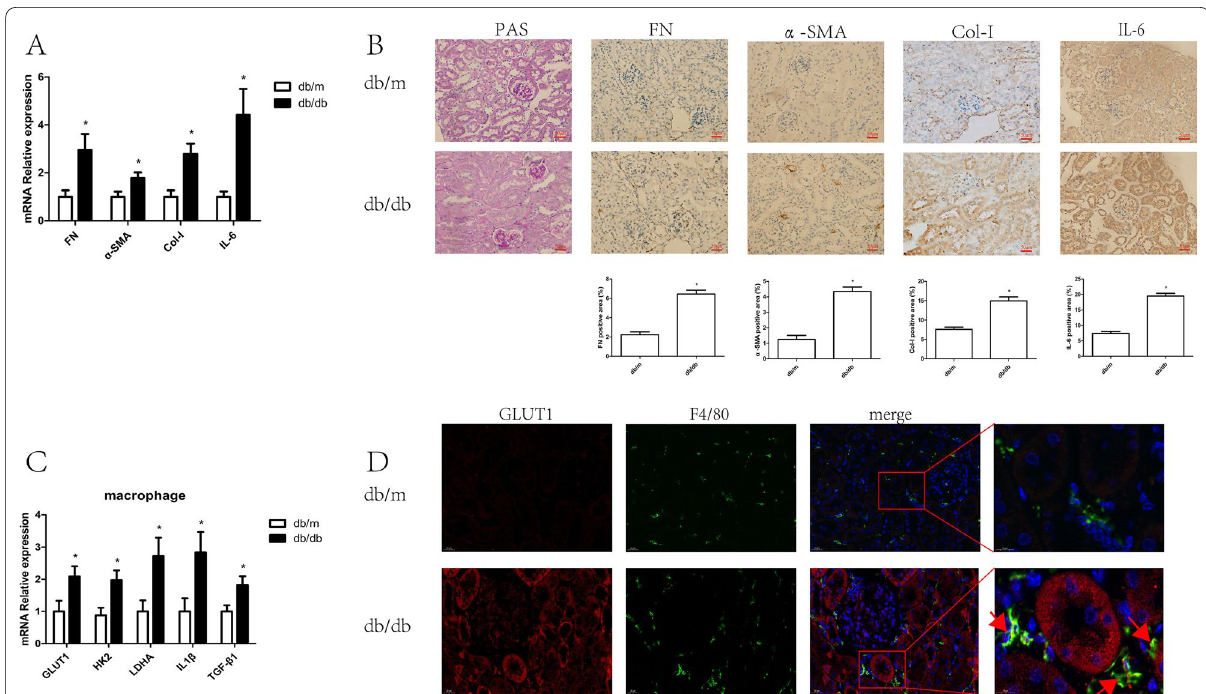
Fig. 1 Glycolysis increased in diabetic kidney macrophages. A The mRNA expression of FN, α-SMA, Col-I and IL-6 in the kidney cortexes of db/m (n 5) and db/db (n 5) mice. B PAS staining and immunostaining of FN, α-SMA, Col-I and IL-6 (original magnification = = of db/m (n 5) and db/db (n 5) mice. C mRNA expression of GLUT1, HK2, LDHA, IL1β and TGF-β1 in the kidney macrophages of db/m (n = = db/db (n 5) mice. D Double immunohistochemistry (IHC) staining of GLUT1 (red) and F4/80 (green) in the kidney cortexes of db/m and db/db = mice. * p < 0.05 vs. db/m